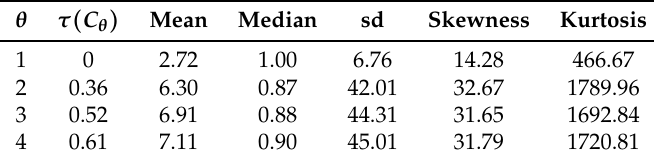
Table 6. Descriptive Statistics for Y = X 1 X 2 when ( X 1 , X 2 ) follows Joe copulas.